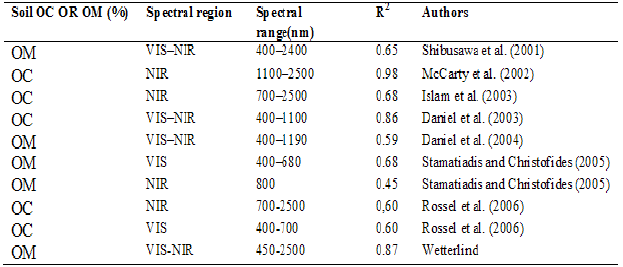
Table 2 A review of the literature comparing quantitative predictions of soil OC or OM using multivariate analyses and spectral response in the VIS, NIR and MIR regions of